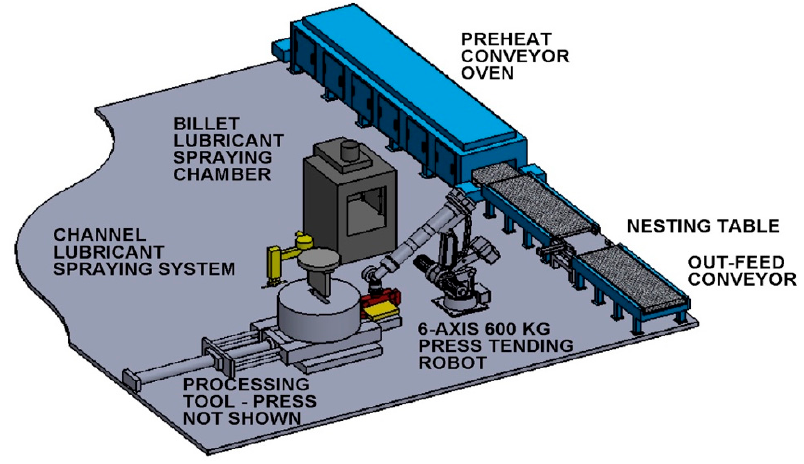
Figure 13. Concept of an automated sc-ECAE processing line.